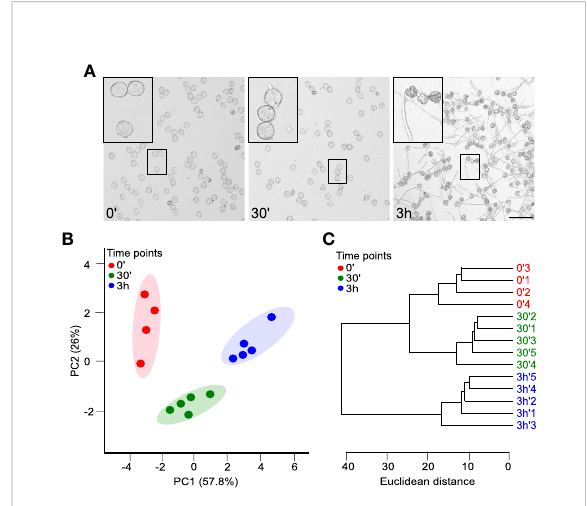
FIGURE 1 Tobacco pollen has a distinct whole-cell lipidome during the establishment and maintenance of cell polarity. (A) Time series of growing pollen tubes monitored at 0, 30 and 180 minutes after germination in liquid medium. Bar =100 µm. (B) Principal component analysis (PCA) of the glycerolipidome based on pollen tubes at 0, 30 and 180 minutes. The shaded areas indicate the 95% con fi dence regions. Samples are colored according to the time of collection 0 ’ (red), 30 ’ (green) and 3h (blue). (C) Dendrogram of hierarchical cluster analysis of individual glycerolipidome samples among pollen tubes at different times 0, 30 and 180 minutes. Both PCA and hierarchical clustering were done using the MetaboAnalyst